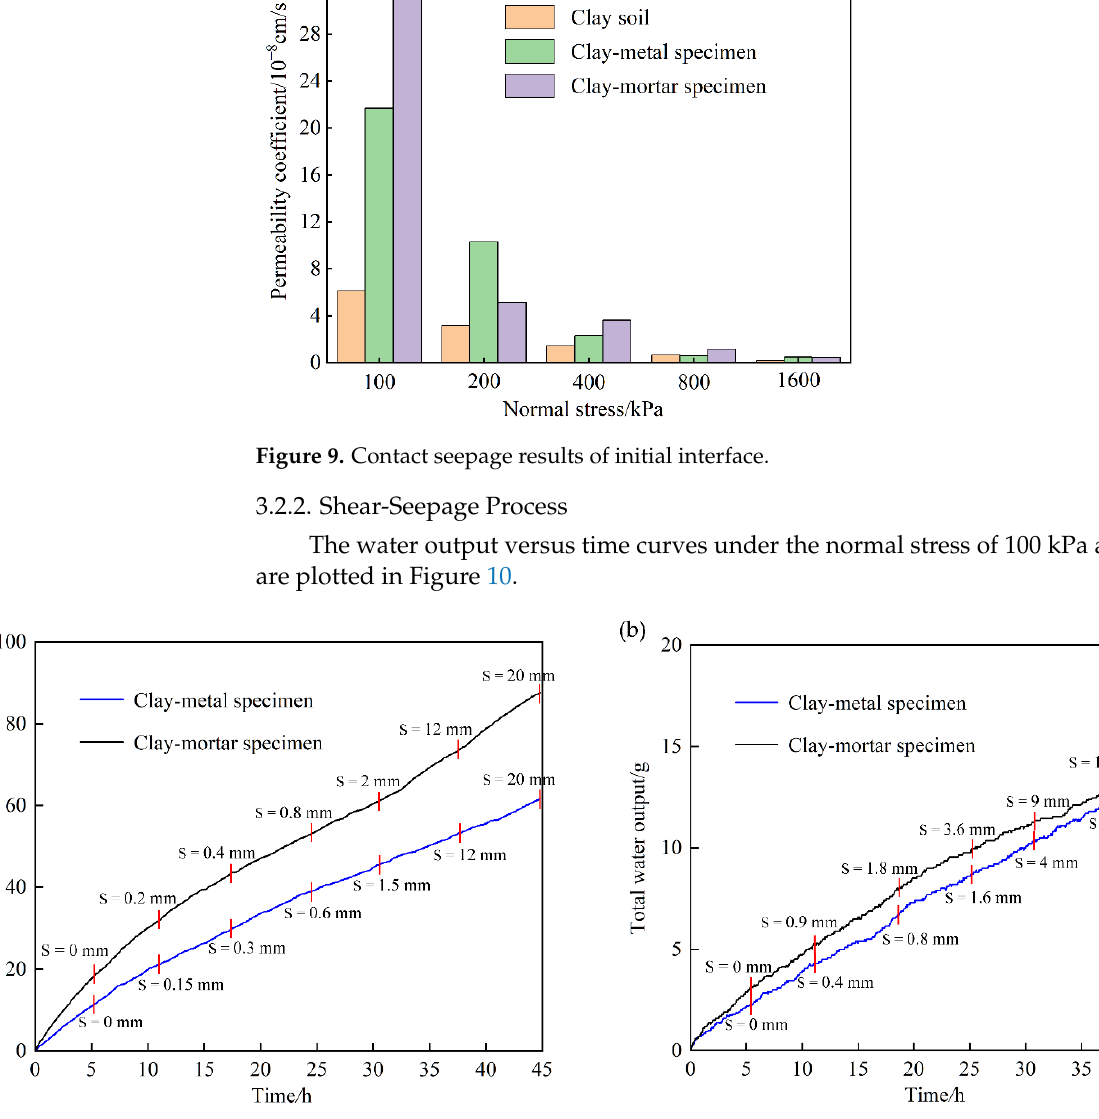
Figure 10. The water output versus time curves under different normal stresses: ( a ) 100 kPa; ( b ) 1600